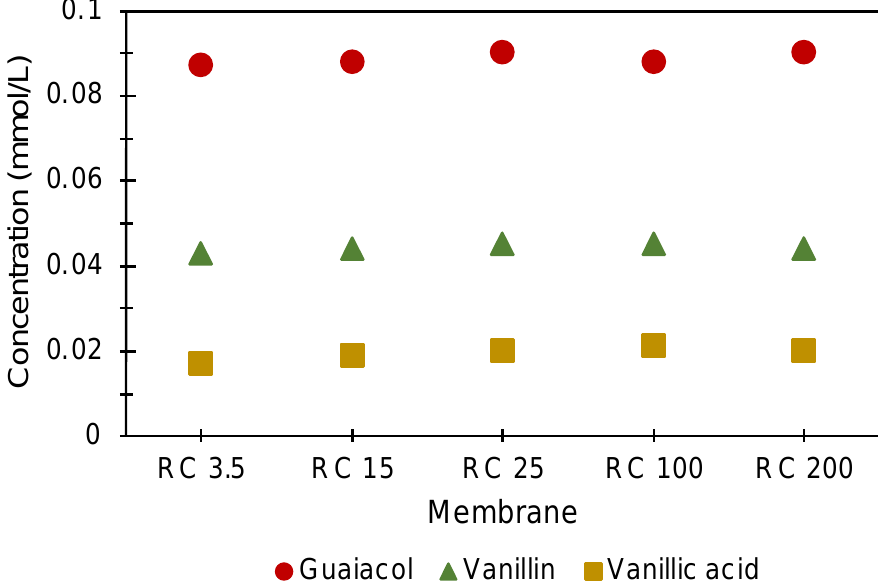
Figure 5. Concentration of various monomers determined from the UHPLC results obtained on the acceptor side of five different membranes.